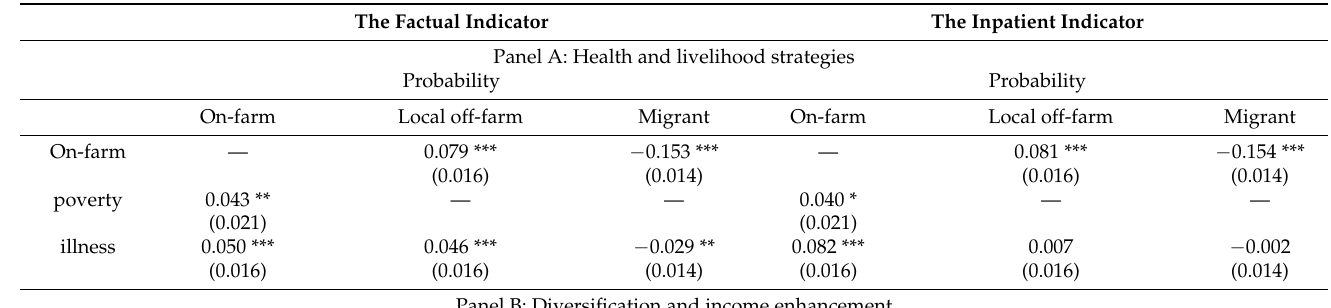
Table 5. Robustness check